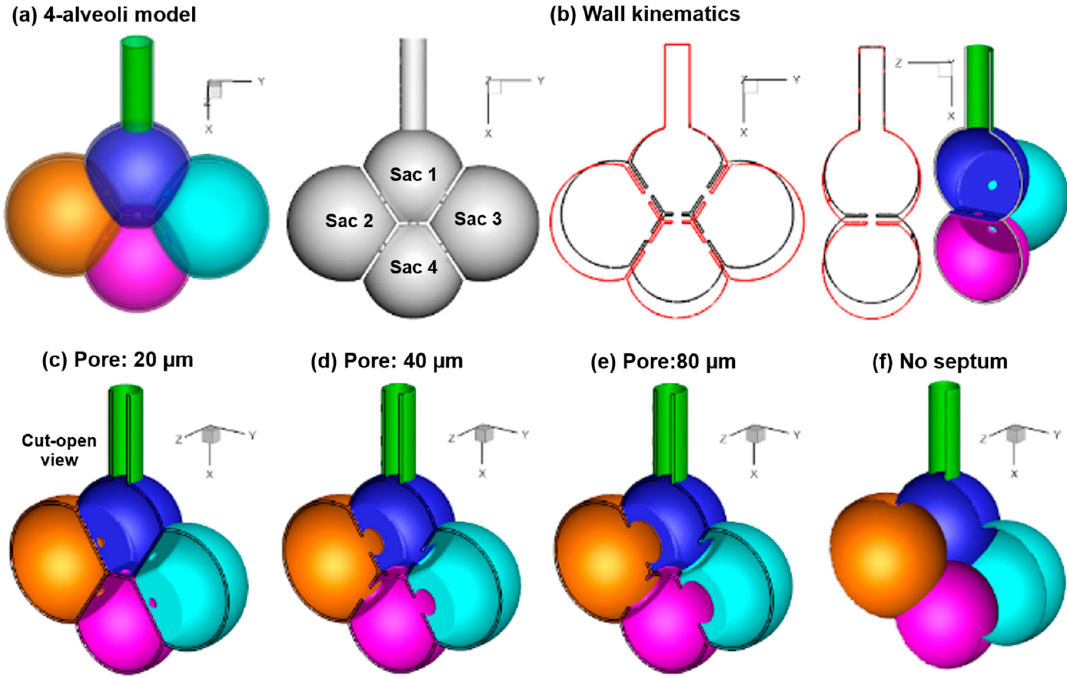
Figure 1. Models: ( a ) Four-alveolar model with septal walls communicated via interalveolar pores, ( b ) alveolar kinematics with rhythmically expanding (red) and contracting (black) walls. Different pore sizes were considered: ( c ) 20 µm, ( d ) 40 µm, ( e ) 100 µm, and ( f ) no septum.